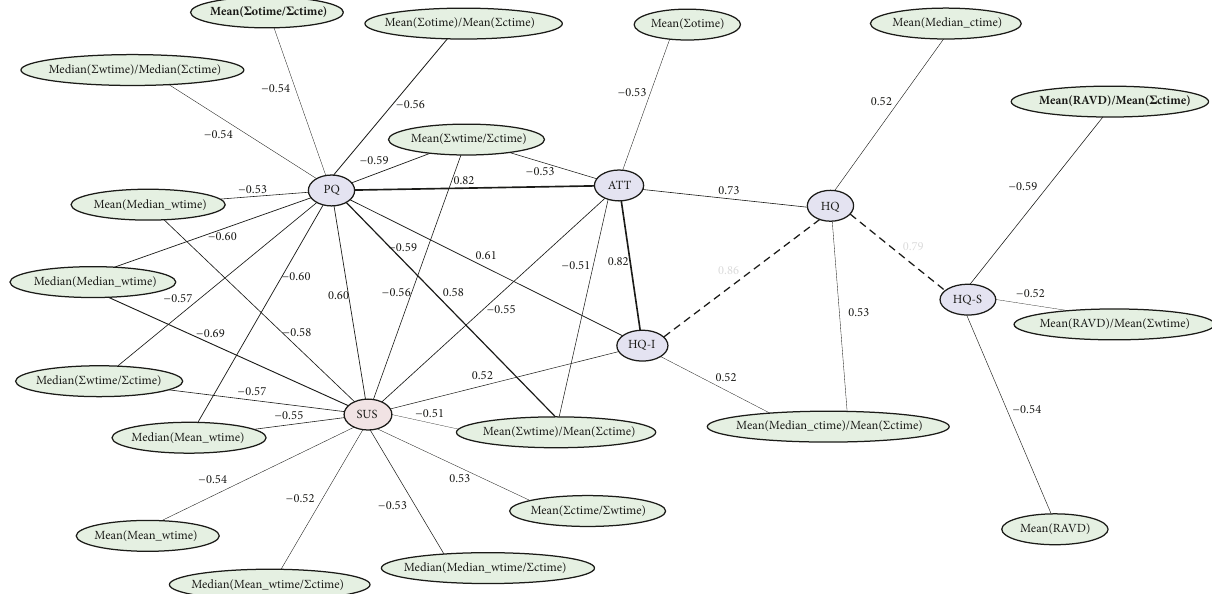
Figure 15: Features from user interaction logs (green) correlated with SUS (red) and AttrakDiff-2 (blue) questionnaire results. Bold feature names highlight top five most important features with regard to GBRFs. Only relations with a Pearson correlation coefficient abs (𝑐) > 0.5 and 𝑝 < 0.05 are displayed. Note that this visualization is an extension to Figure